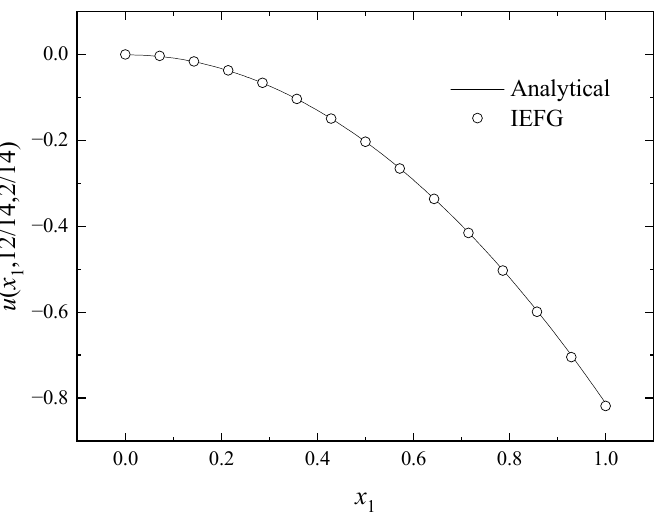
Figure 19. The comparison of numerical and exact solutions along x 1 -axis.